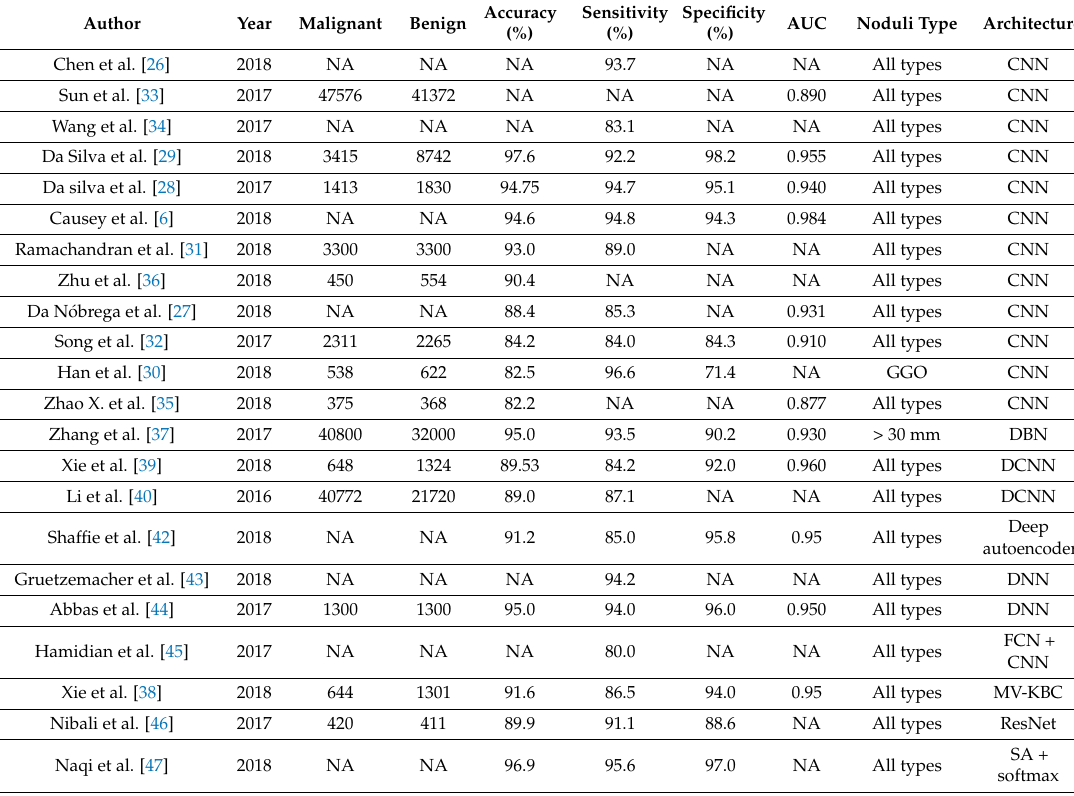
Table 2. Deep learning algorithms applied to the LIDC-IDRI